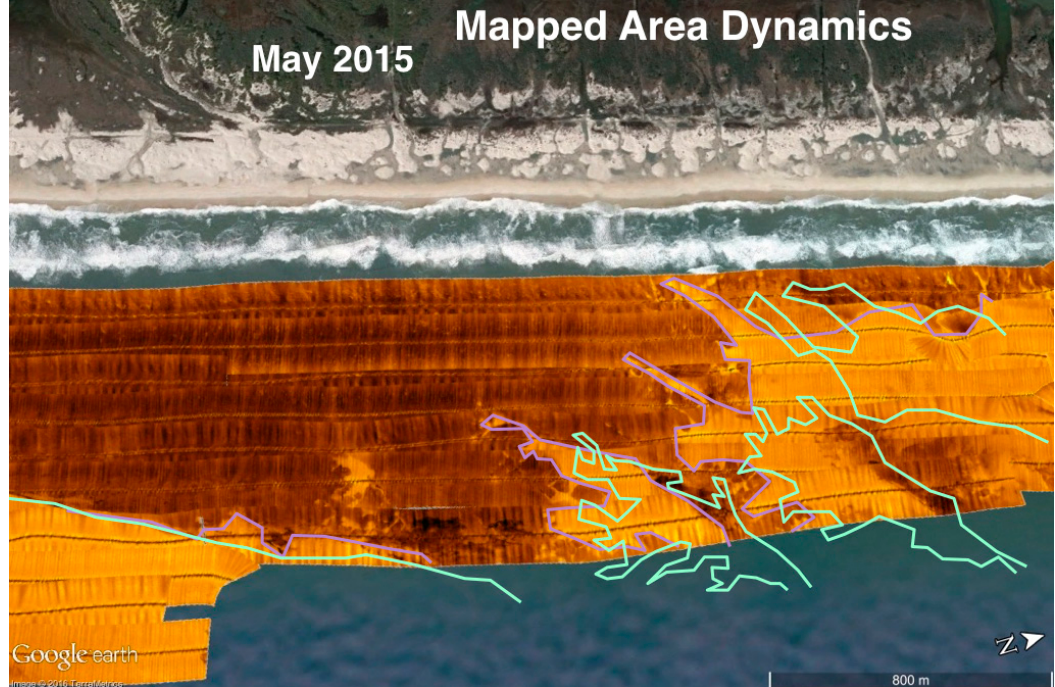
Figure 11. May 2015 side-scan mosaic and sediment classification shapefile compared to 2011 from Figure 9.